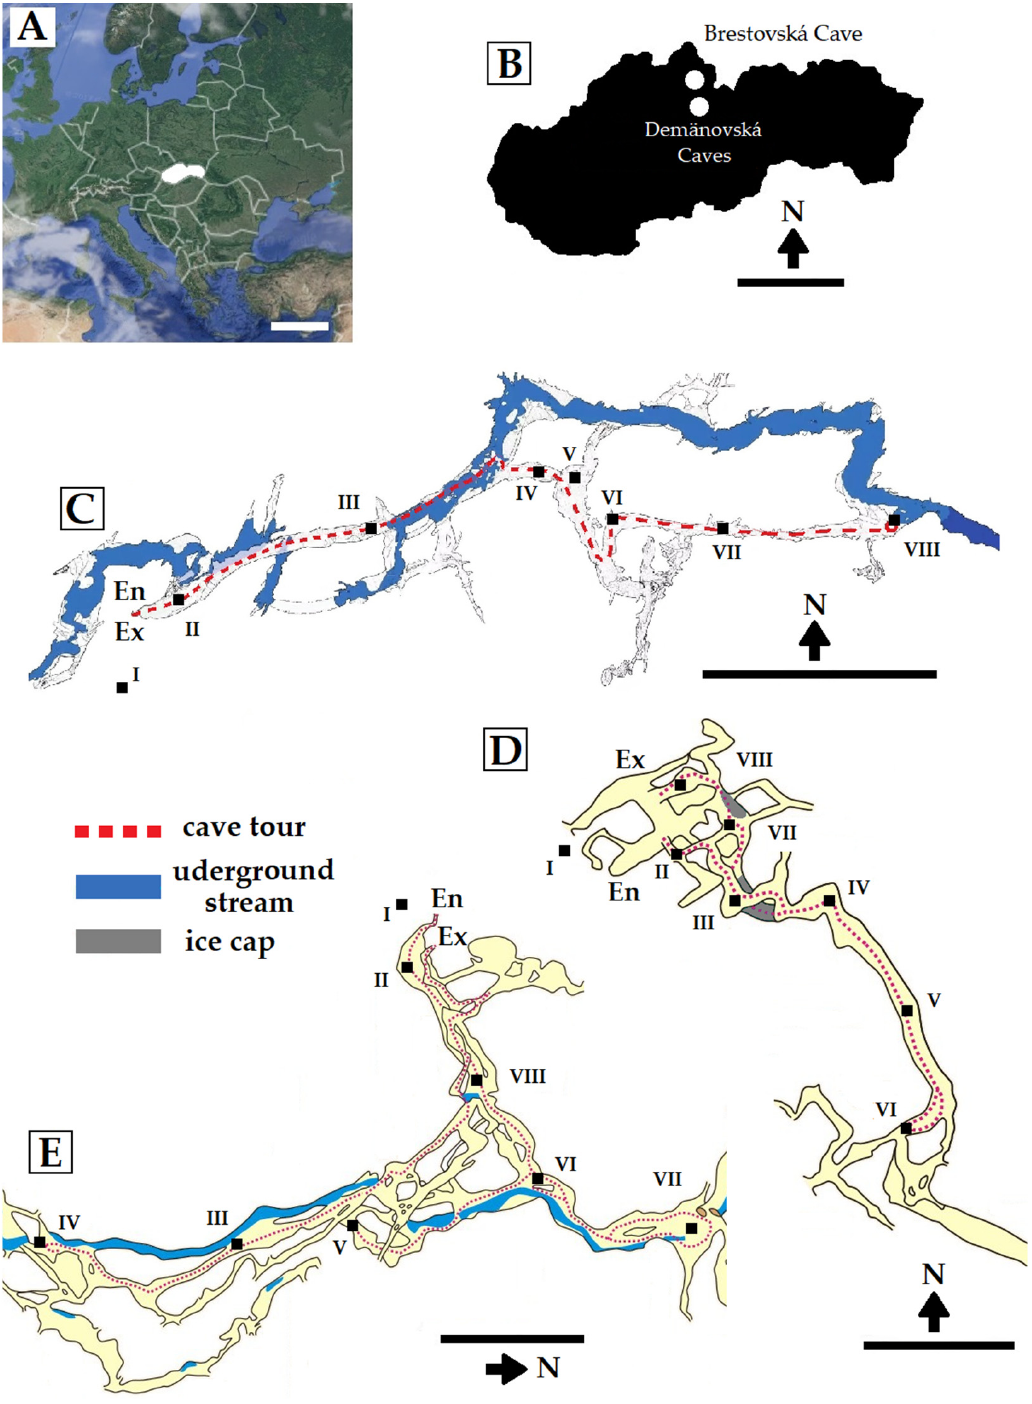
Figure 1. Geographic location of Slovakia ( A ) and the studied caves ( B ). Entry (En) and exit (Ex) from the Brestovská Cave ( C ), the Demänovská Ľ adová Cave ( D ), and the Demänovská Slobody Cave ( E ). Underground corridors with marked sampling locations on the tourist route: location I outside the caves, and locations II to VIII inside the caves. Scale bars: ( A ) = 500 km, ( B ) = 100 km, ( C ) = 50 m, ( D , E ) = 100 m.